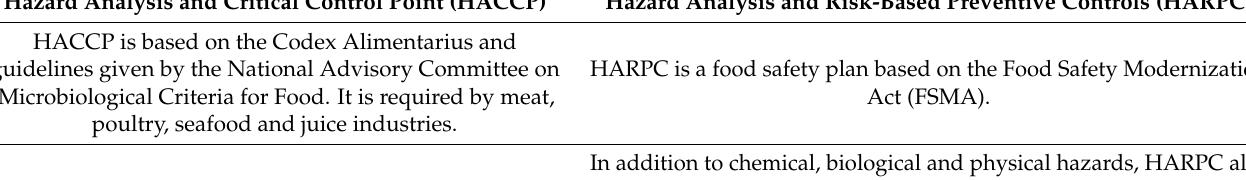
Table 6. Differences between HACCP and HARPC in terms of various elements of food safety plans [44,46]. Hazard Analysis and Critical Control Point (HACCP) Hazard Analysis and Risk-Based Preventive Controls (HARPC) HACCP is based on the Codex Alimentarius and guidelines given by the National Advisory Committee on poultry, seafood and juice